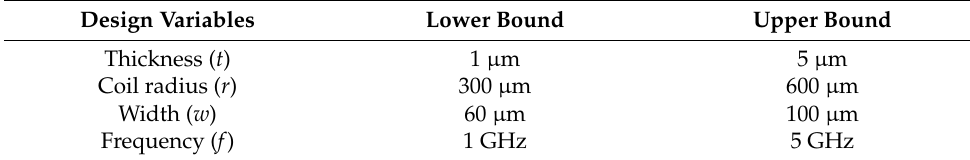
Table 1. Design variables for RF-MEMS inductor.